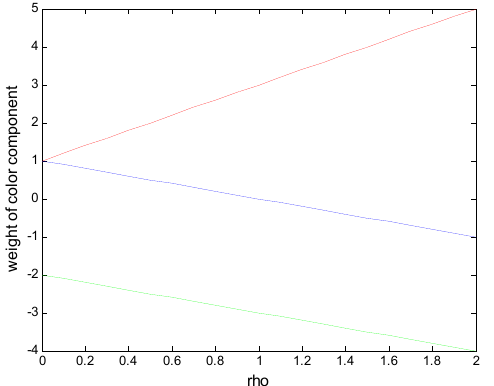
Figure 2. Influence of ρ on the weighting of each color channel in the Forest Fire Detection Index (FFDI). This means that lower values of ρ enhance colors with a high amount of red compared to the other channels, i.e. , reddish tones. Bigger values of ρ between 0 and 1 (0 < ρ ≤ 1) cause an enhancement of the yellow and brown tonalities, which are around the red ones because the blue channel is canceled out. With a further increase of ρ , up to two brighter colors (bright yellow in the center of the flame) and whiter or grayer ones (smoke) will be detected because they are composed of almost equal RGB values. For better distinguishing them, it is necessary to increase the red component.